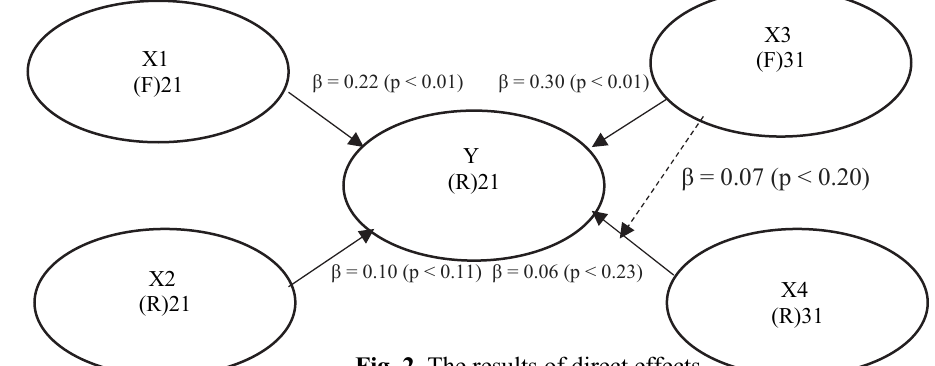
Fig. 2. The results of direct